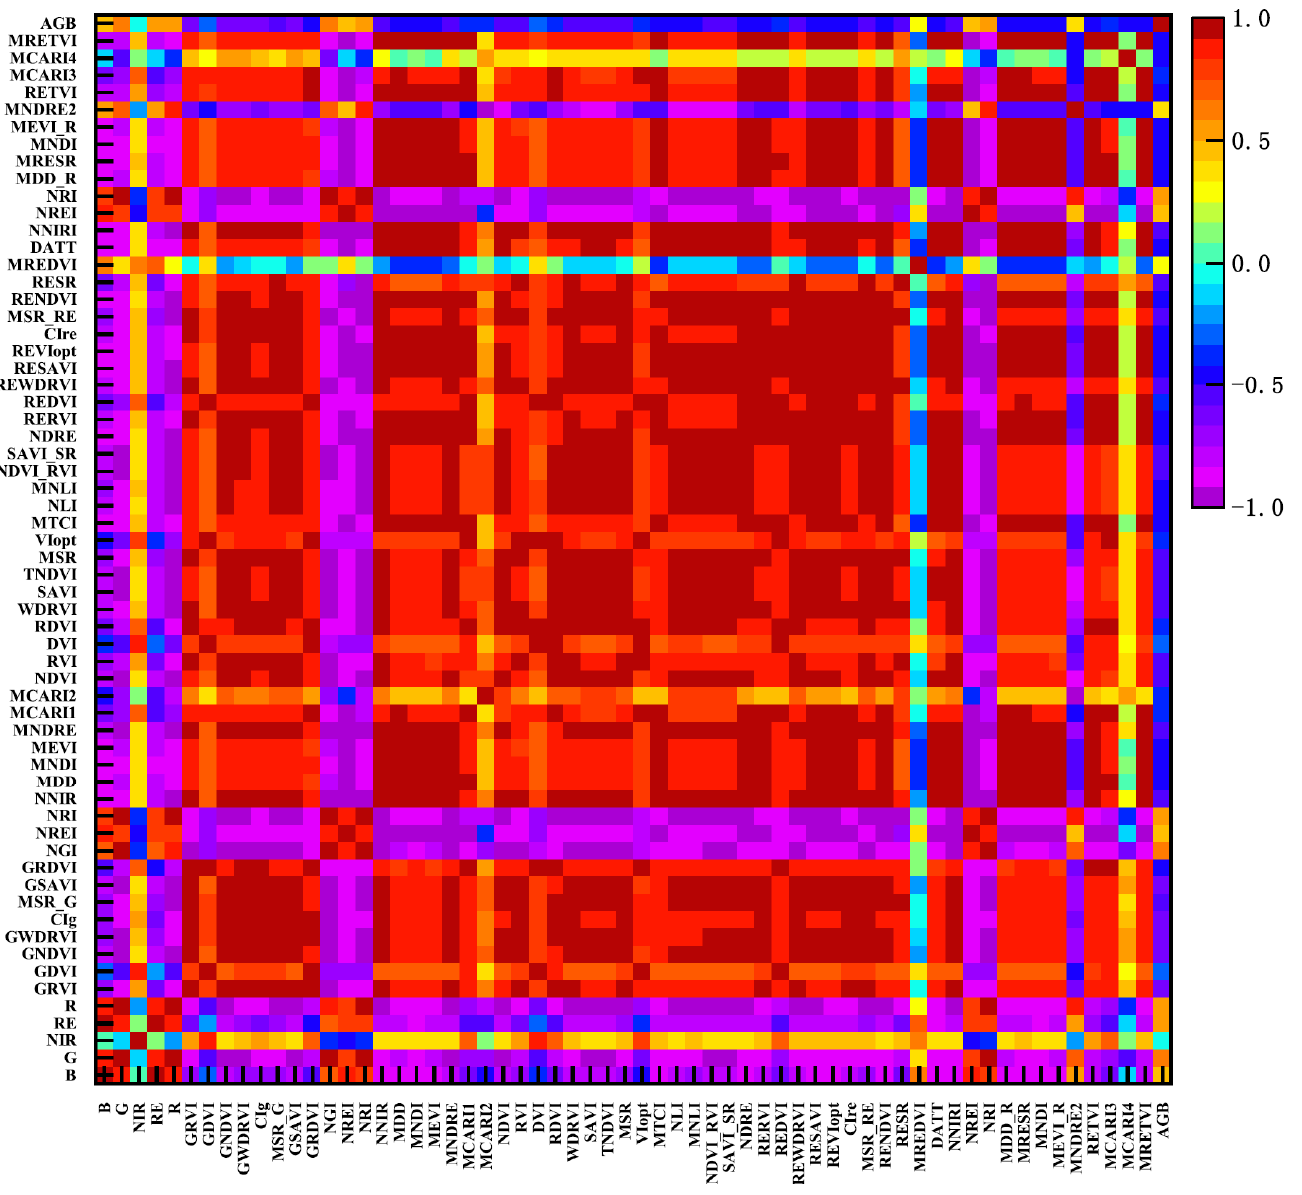
Figure 3. Relationship of bands, Vis, and AGB. Table 5. Top three VIs for estimating AGB based on six different ML models.